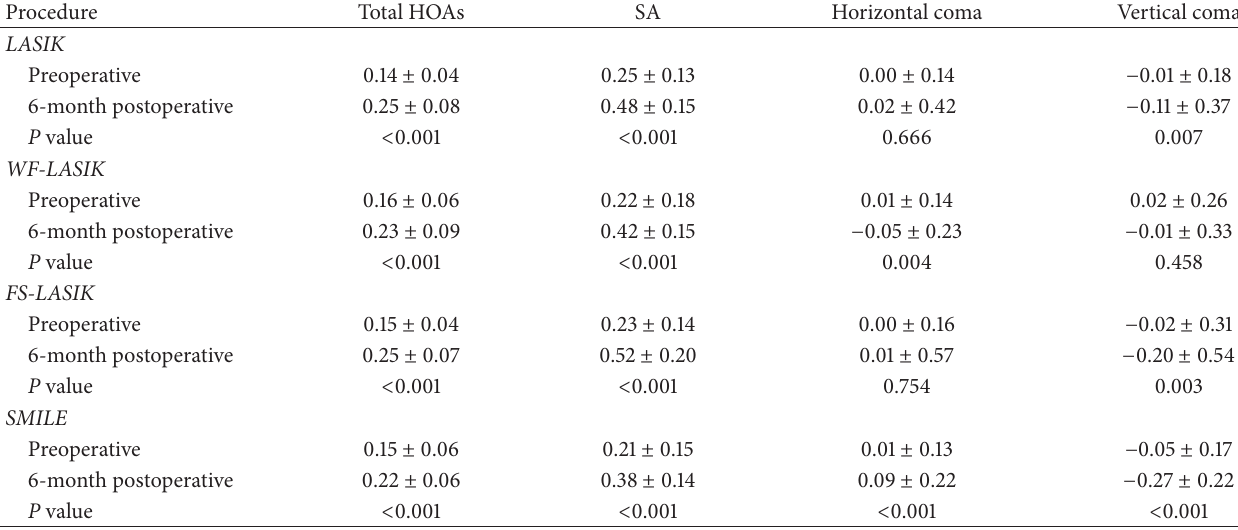
Table 2: Preoperative and 6-month postoperative anterior corneal HOAs with 6 mm diameter central corneal zone (mean ± SD, 𝜇 m).